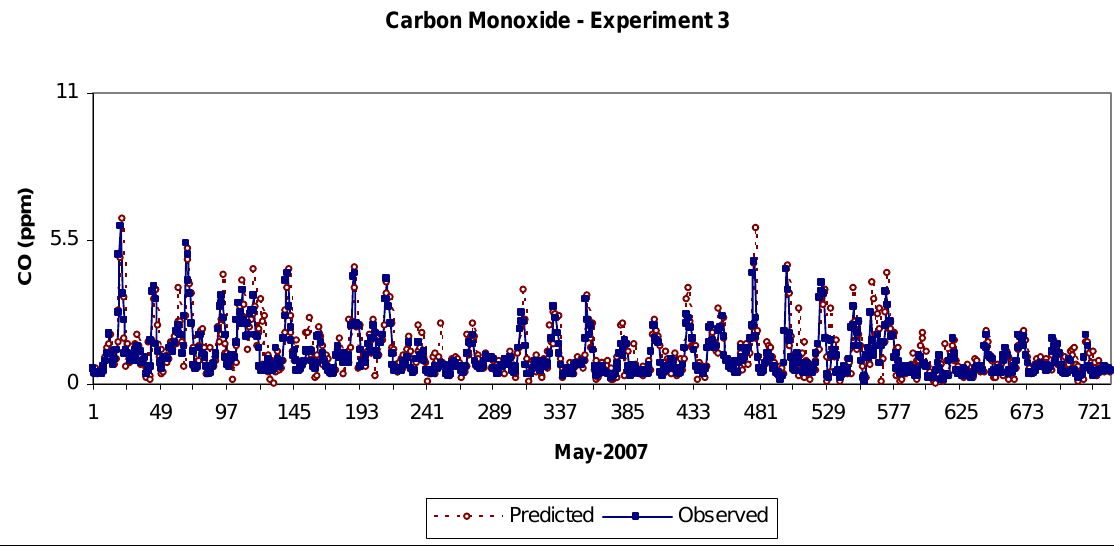
Fig. 3. Experiment 3 results: predicted vs observed time